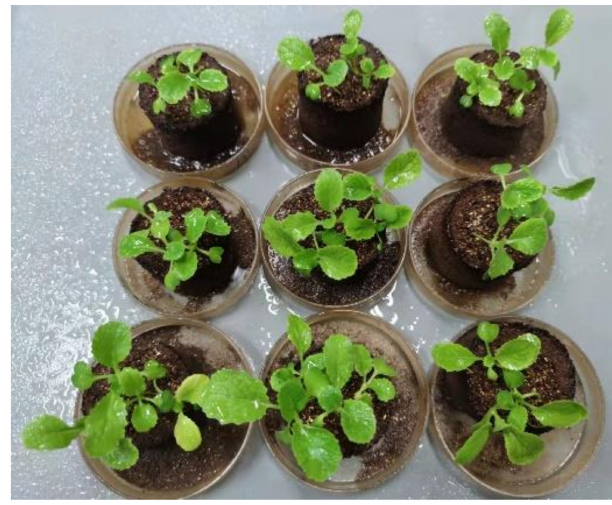
Figure 7. Nursery test of rabbit manure compost seedling nursery